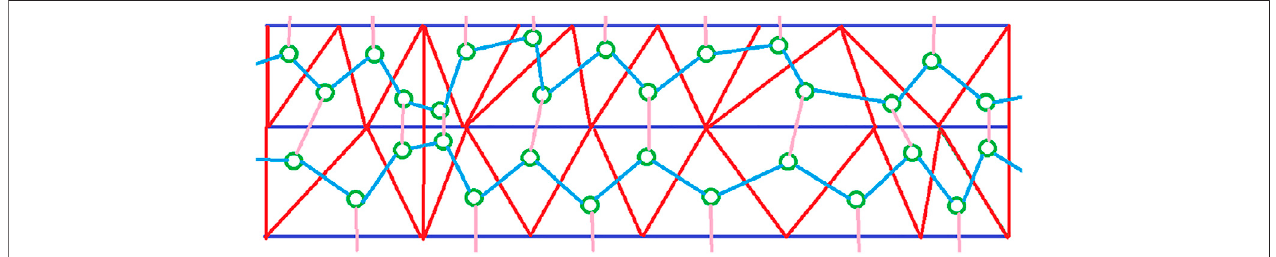
FIGURE 1 | Part of a dual triangulation to a Feynman graph. The solid colors red and blue indicate the time- and space-like boundaries of dual triangles, the light colors the dual propagators in the Feynman graph and the green circles the vertices in the Feynman graph. The important fact to note is that having precisely two pink propagators in each closed loop implies that theblue lines foliate the entire Feynman graph.Notice that we drew the propagators assingle lines to notclutterthe picture too much; the usual depiction of the matrix model propagator would be though a double line, i.e. line one for each contacted index.